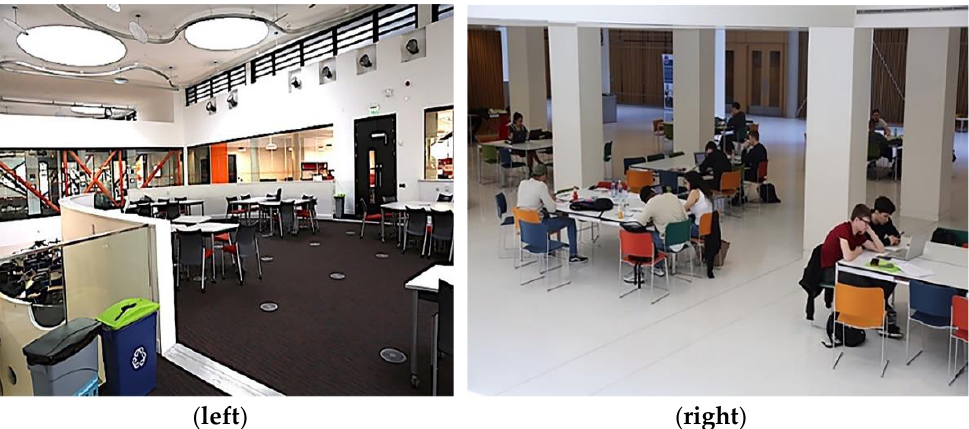
Figure 8. Reconfigurable tables and removable chairs allow students to shape their learning spaces individually or by group in open space at Diamond ( left ) and corridor space at Newton ( right ).